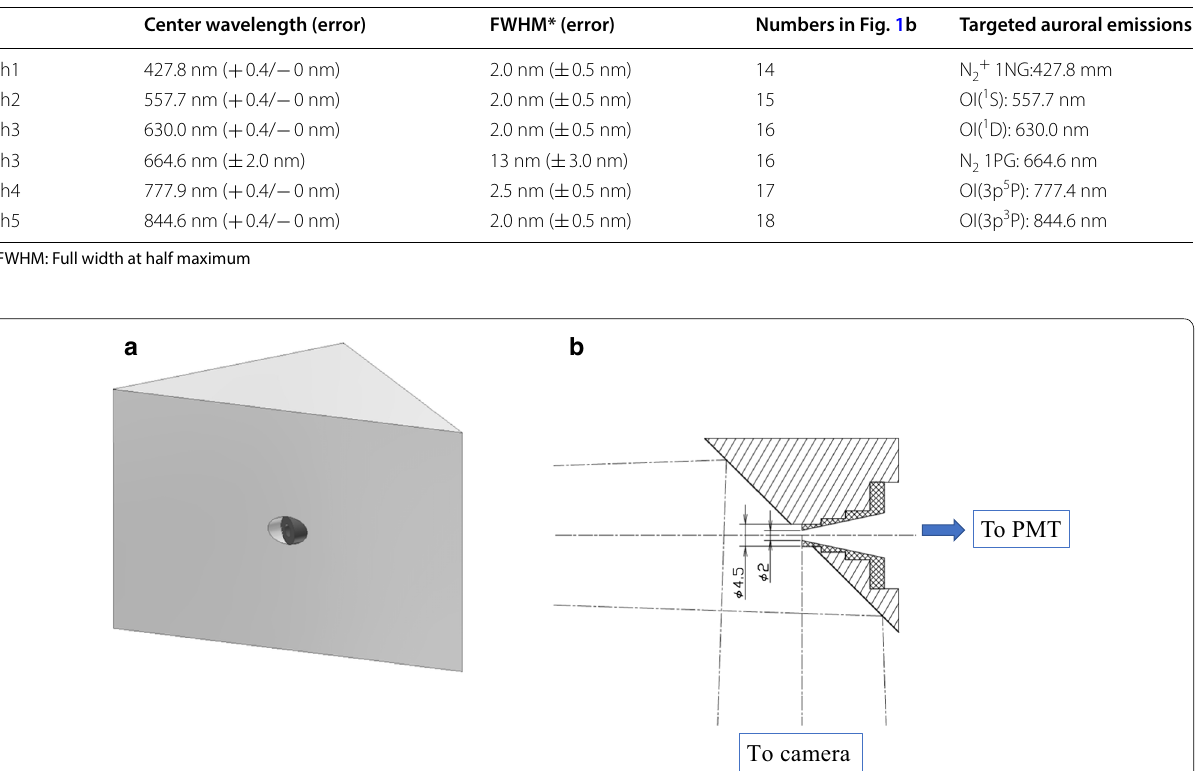
Table 2 List of bandpass filters produced by Andover Inc.